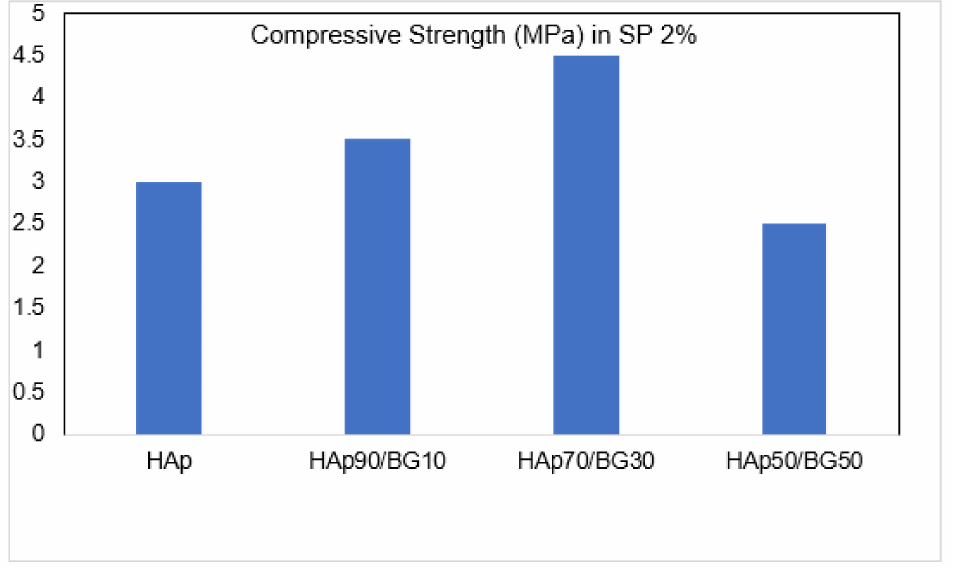
Figure 8. Effect of HAp/BG ratio on compressive strength of cements with SP concentration of 2% (mean ± SD; n = 3, p <